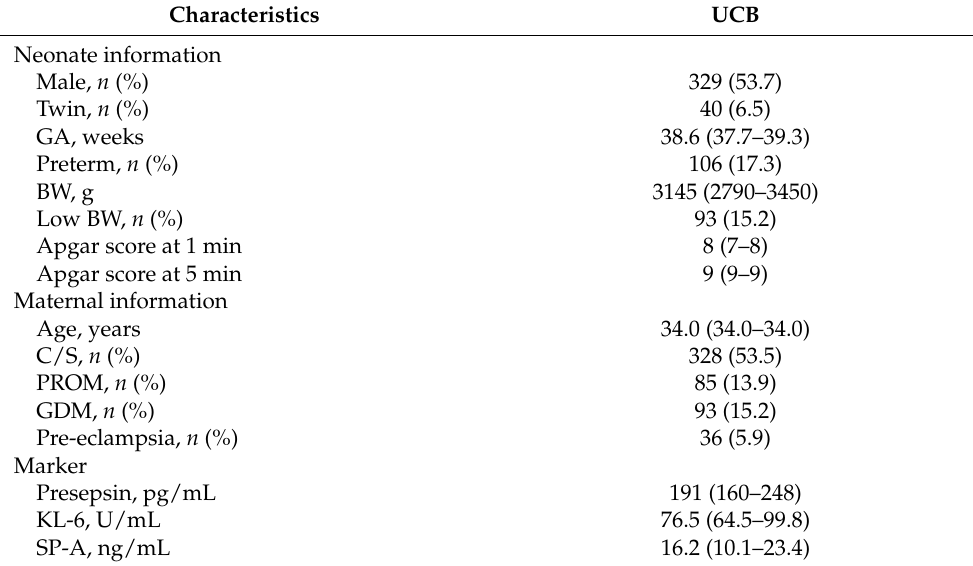
Table 1. Characteristics of the study population ( n =